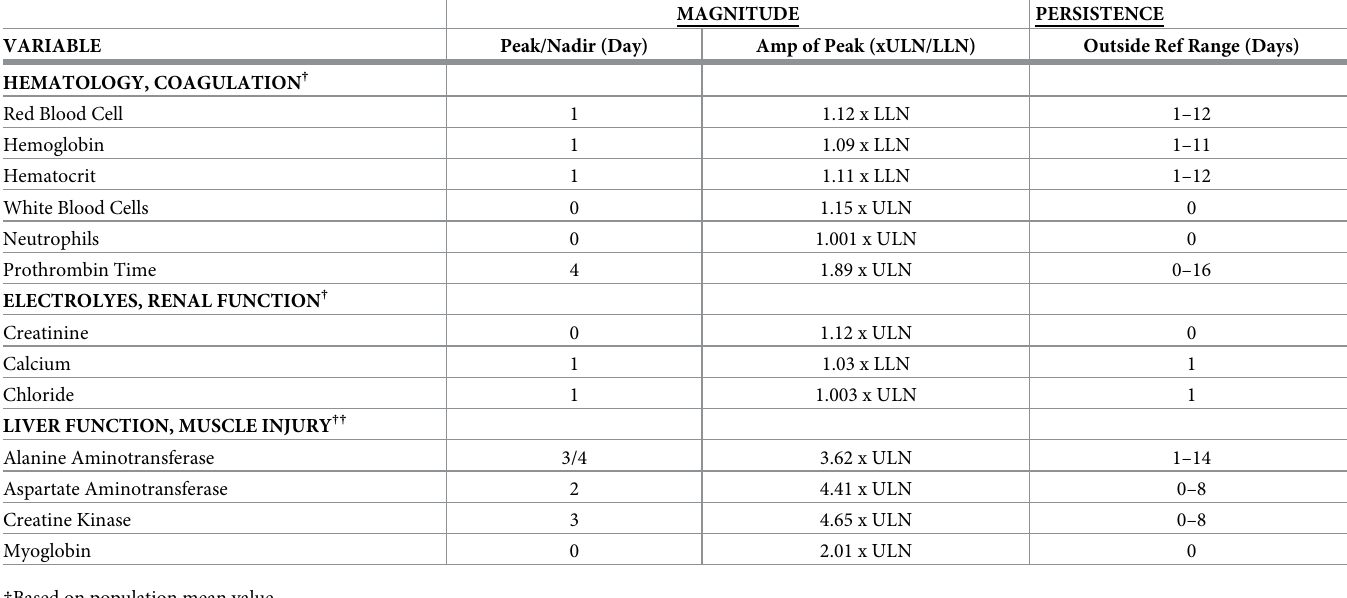
Table 2. Summary of biomarker disturbances, magnitude and